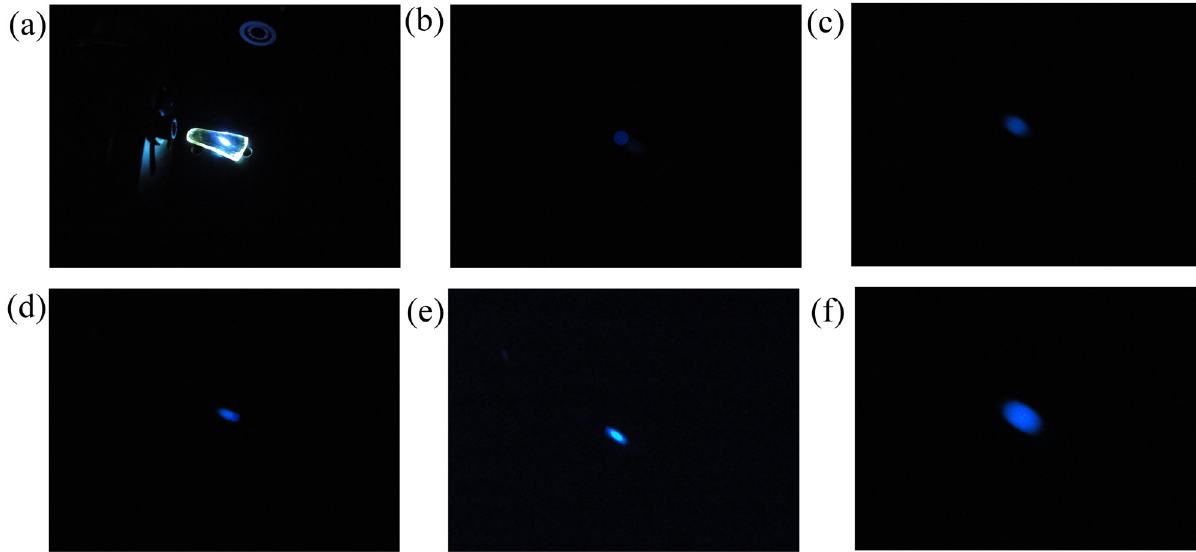
Figure 7: Luminescent photographs of the YVO 4 ( a ) and Ce 3 + - doped YVO 4 single crystals excited at 325 nm ( Doping concentration is x = 0.005 ( b ) , 0.01 ( c ) , 0.02 ( d ) , 0.05 ( e ) , and 0.06 ( f ) , respectively )